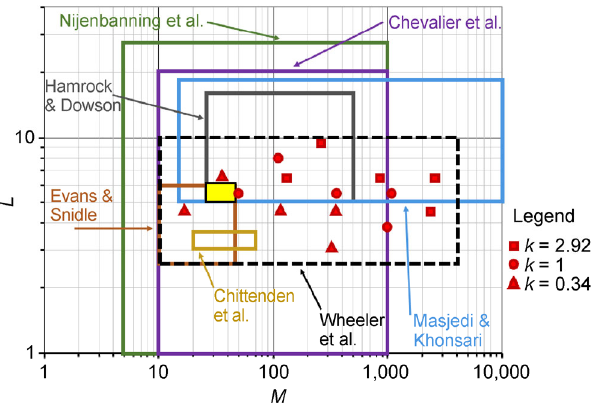
Fig. 1 Domains (expressed by empty rectangles) on which EHD film thickness equations for circular and elliptical contacts were established. The yellowed area represents the common area covered by all the analytical expressions considered here. The black bold dotted line indicates the region where the full numerical model was applied in Ref. [11]. The symbols show the domain corresponding to the 5 references cases of Table 1, in the circular ( k = 1) and the elliptical configurations ( k = 2.92 or